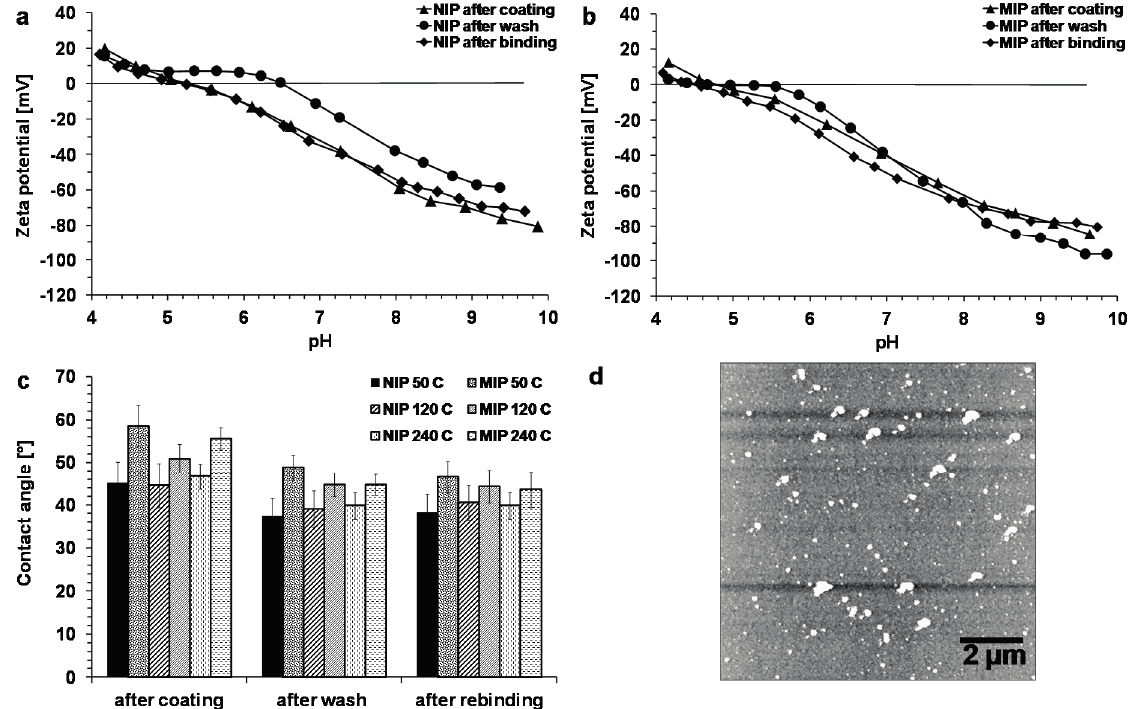
Figure 8. Surface analyses. ( a , b ) Zeta potential measurements of NIP (a) and MIP (b); ( c ) Contact angle measurements of MIP and NIP (40 mM pyrrole); ( d ) AFM 10 µm scan (mean fit) of MIP (40 mM pyrrole, 1 mM clofibric acid, 120